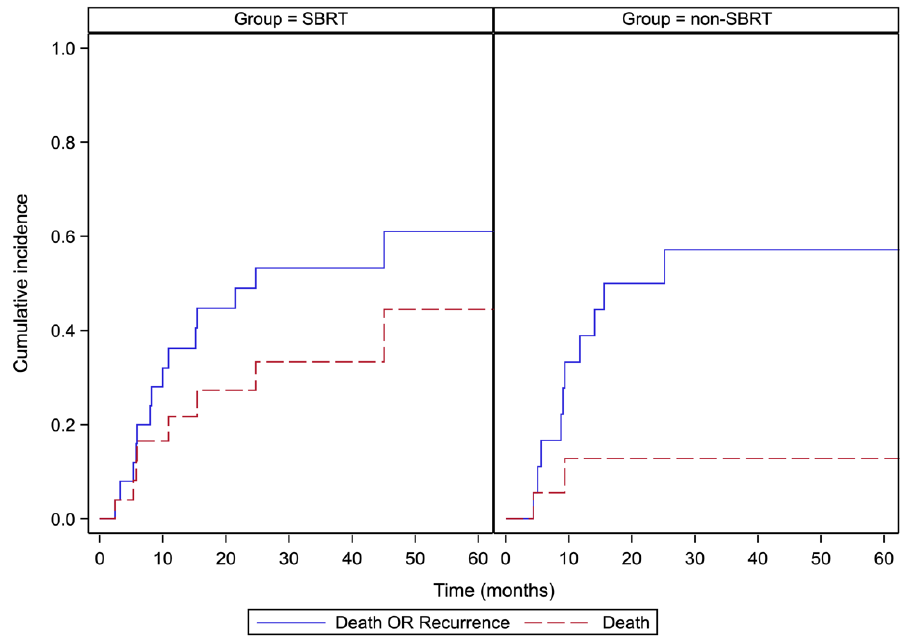
Figure 2. Cumulative incidence of death or recurrence versus death.